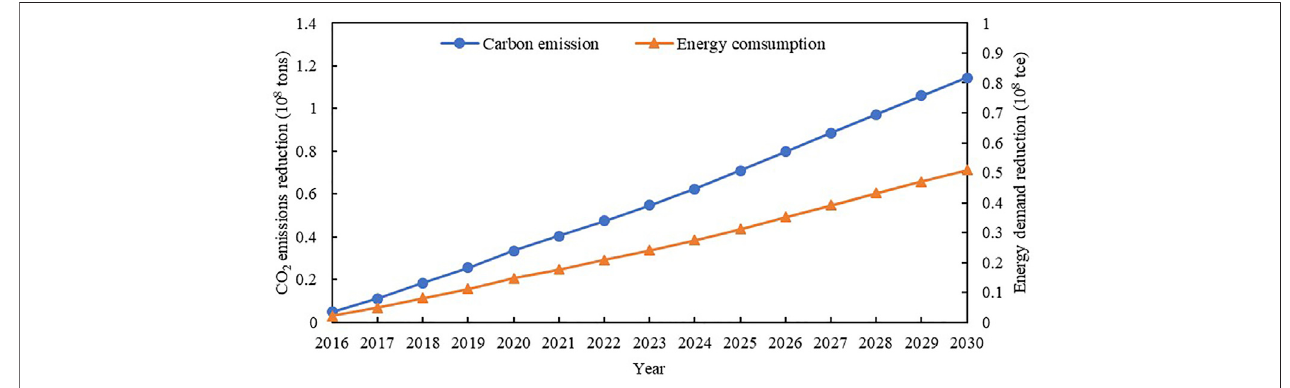
FIGURE 3 | The reduction of energy demand and CO 2 emission in Guangdong Province under low-carbon scenario compared with the baseline scenario.